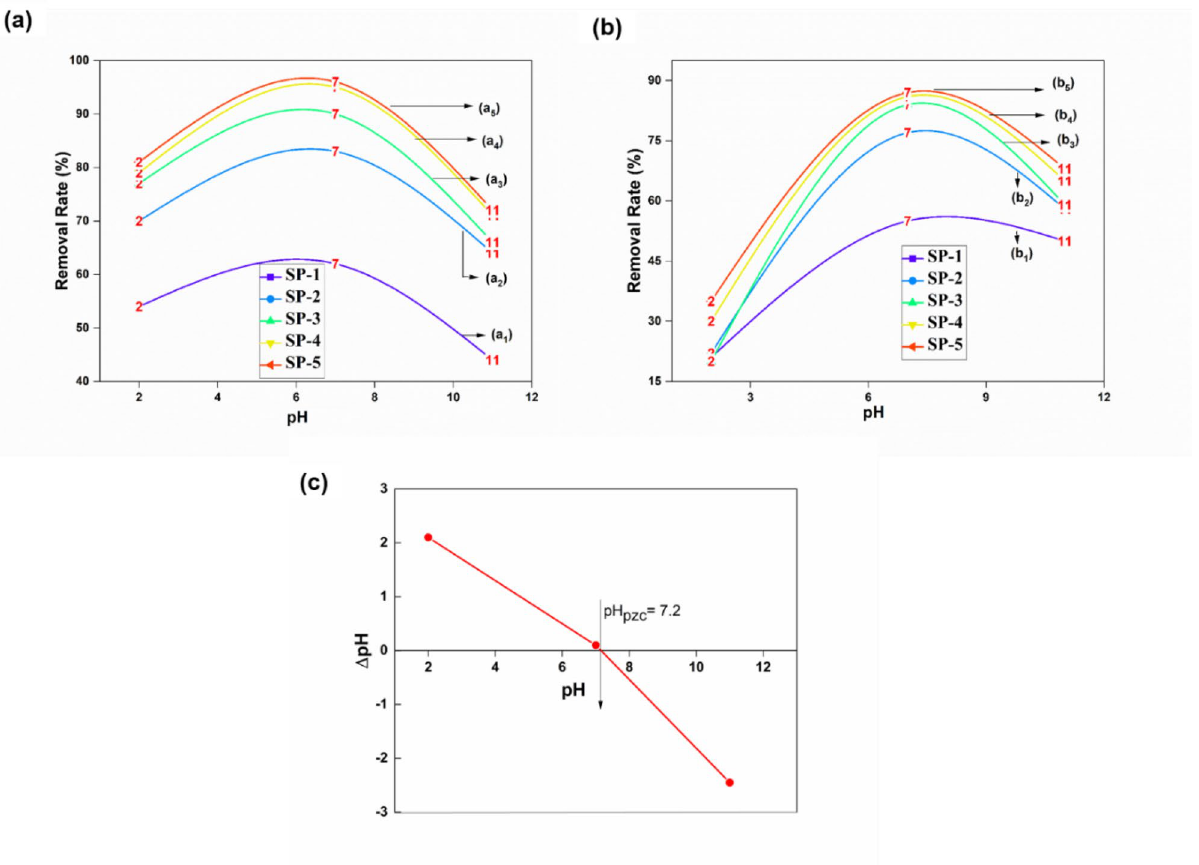
Figure 4. Effect of pH on adsorption removal of ( a ) Cd(II), and ( b ) Pb(II) by SP-1 and SP-2, 3, 4, 5 ENMs, ( c ) pH pzc plot of SP-5